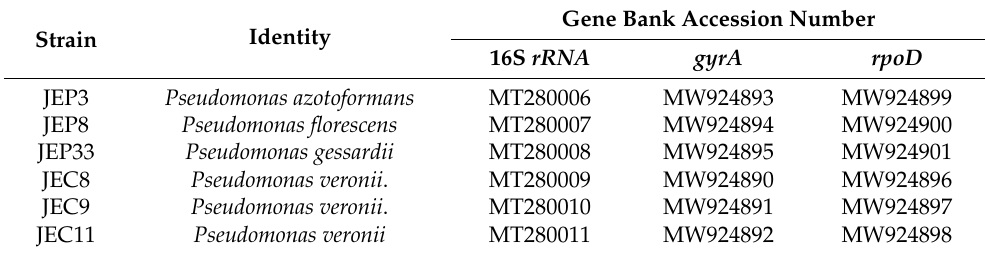
Table 1. Molecular identification of heavy metal resistant-endophytic bacteria.